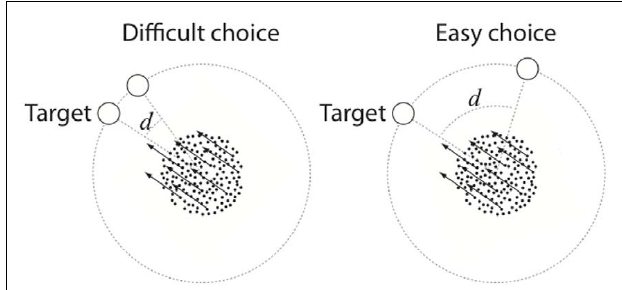
FIGURE 1 | RDM stimulus display. A proportion of the dots move in a target direction indicated by the arrows, while the remaining dots move randomly.The discriminability of the target is manipulated by changing the angular distance ( d ) between the